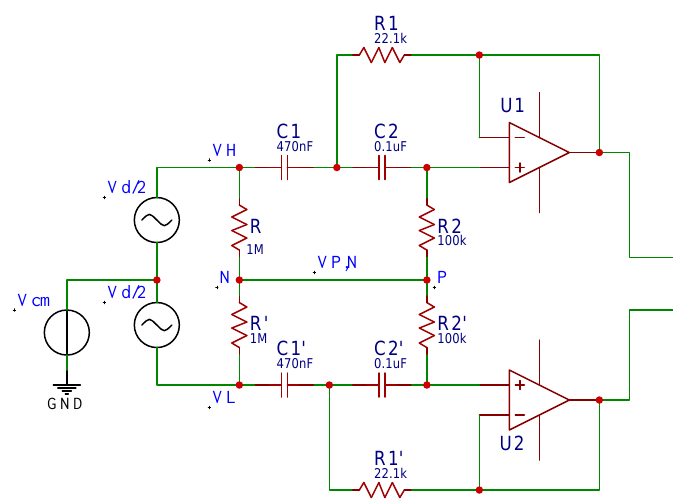
Figure 5. Schematic of the active high-pass filter, adapted from